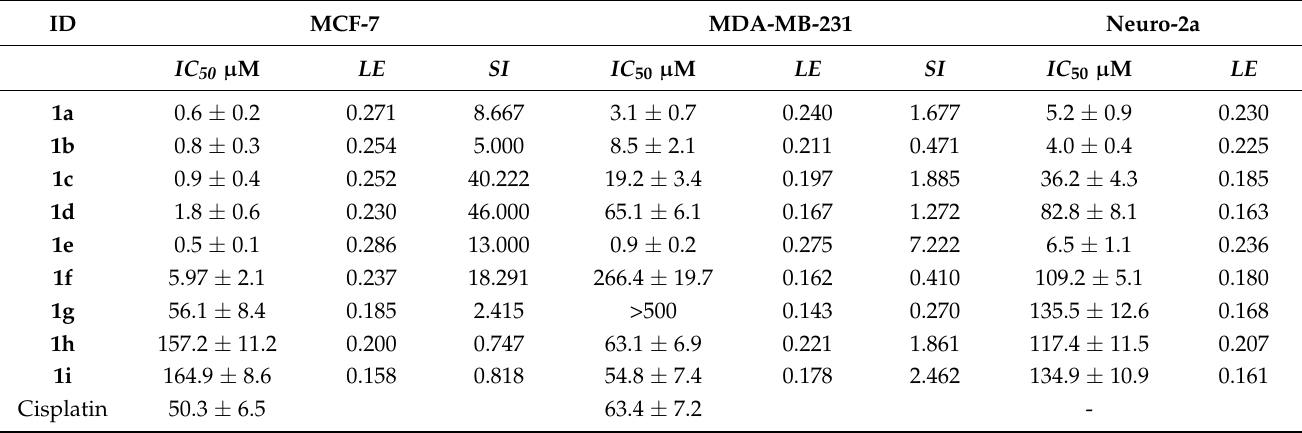
Table 6. Cytotoxicity of the designed arylsulfonylhydrazones on MCF-7, MDA-MB-231, and Neuro-2a cell lines. LE —ligand efficiency; SI —selectivity index ( IC 50 on Neuro-2a/ IC 50 on BC cell